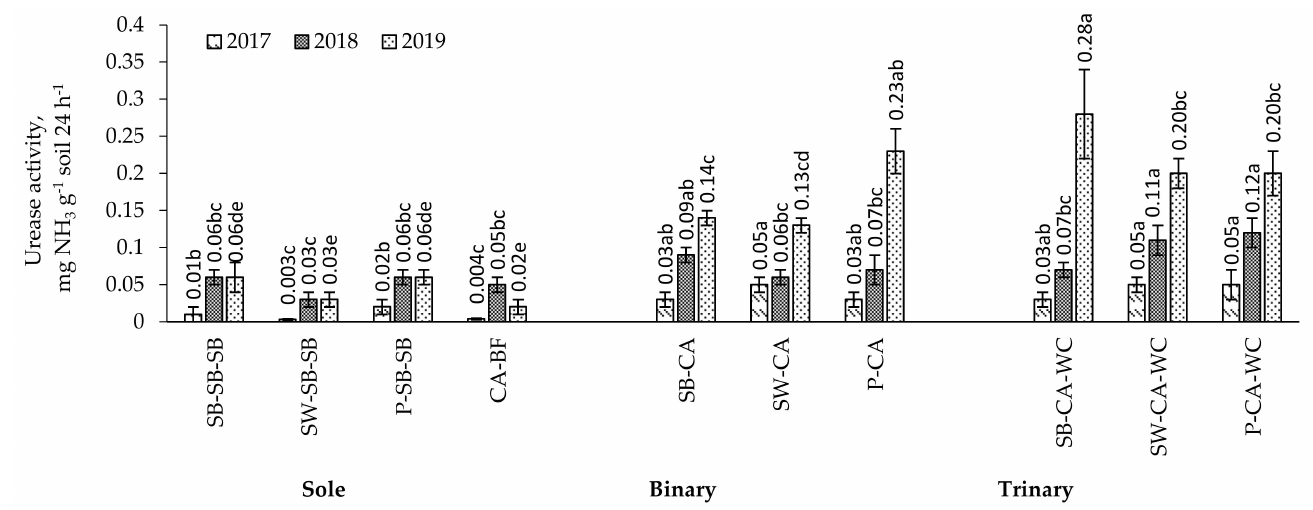
Figure 3. Urease activity in sole, binary, and trinary crops in 2017–2019. Note. CA—caraway, SB— spring barley; SW—spring wheat; P—pea; WC—white clover; BF—black fallow. Differences between the averages of treatments marked with different letters (a, b, c, d, e) are significant ( p < 0.05); error bars indicate the standard